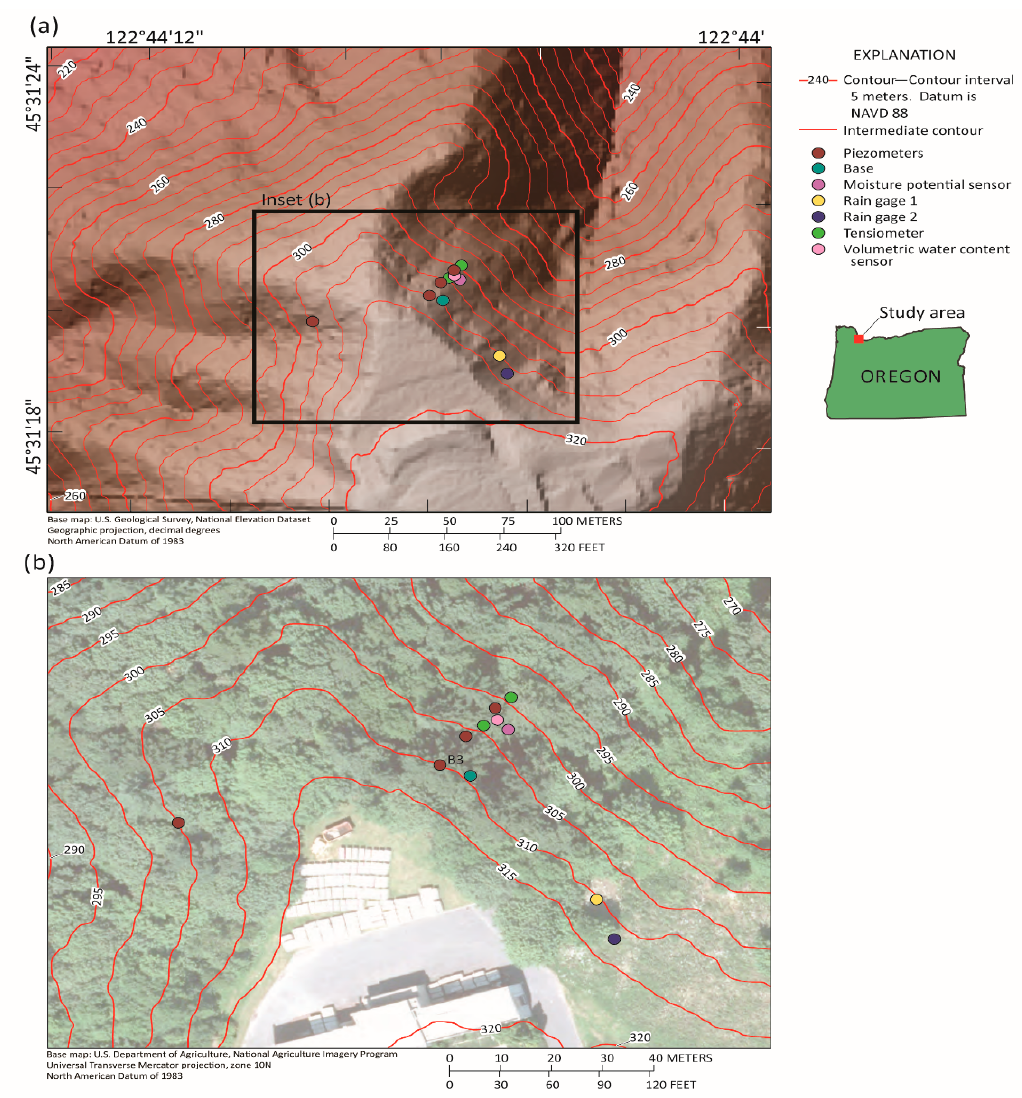
Figure 3. ( a ) Map of the Portland Hills monitoring site in Portland, Oregon, USA, on shaded hillslope image with topographic contours; ( b ) Detail showing various instrument locations on aerial image. Reproduced from Smith et al., 2017 [25].